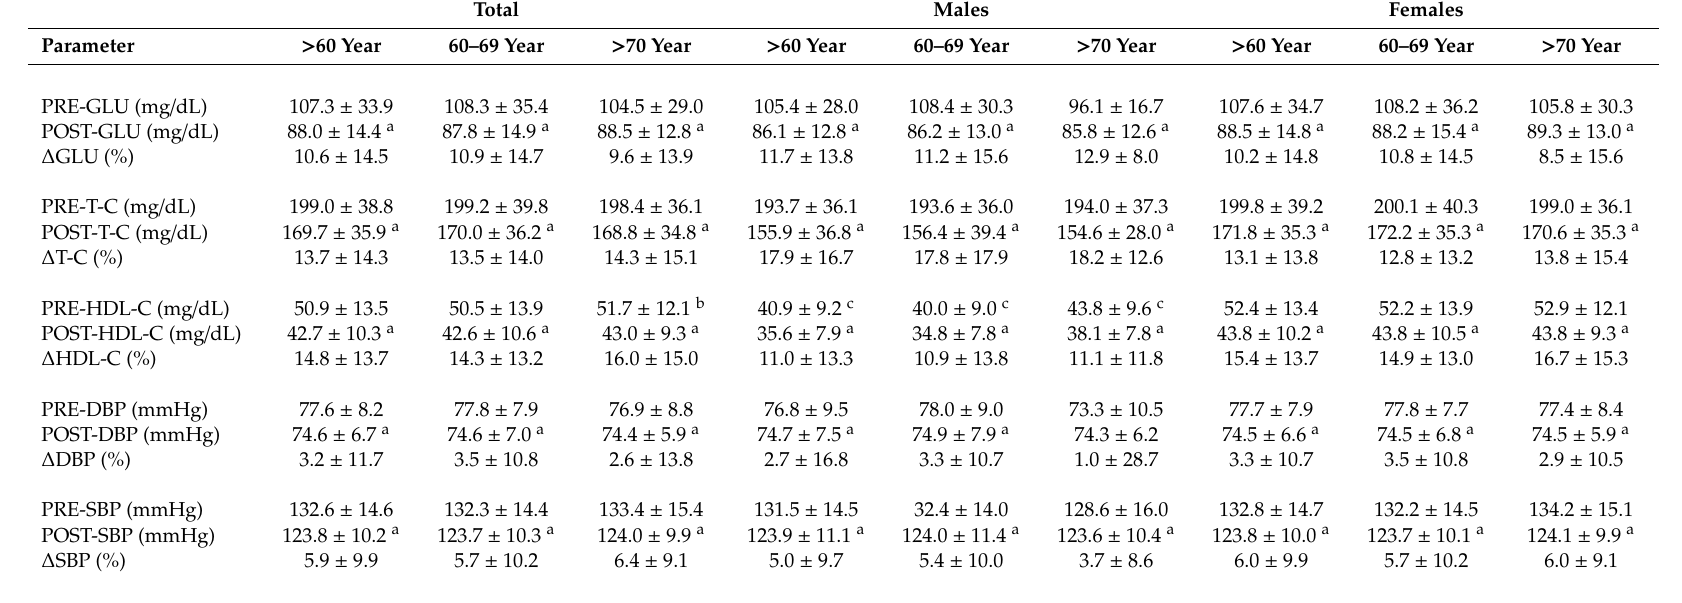
Table 2. Biochemical and cardiovascular parameters of the study population (before and after